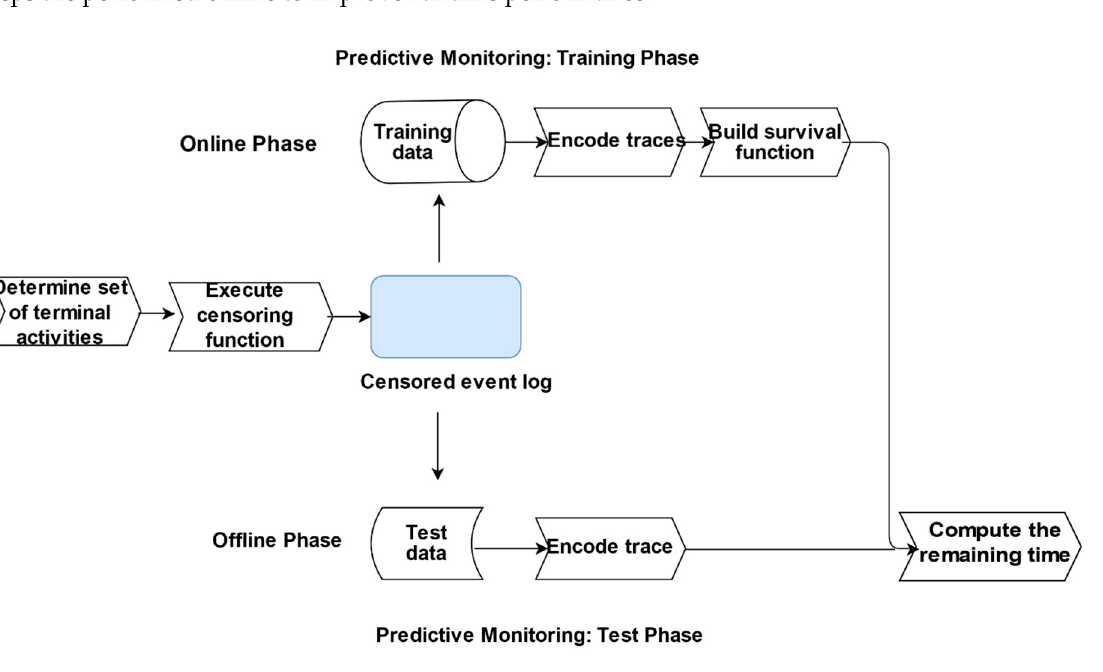
Figure 2. Overview of the proposed approach.